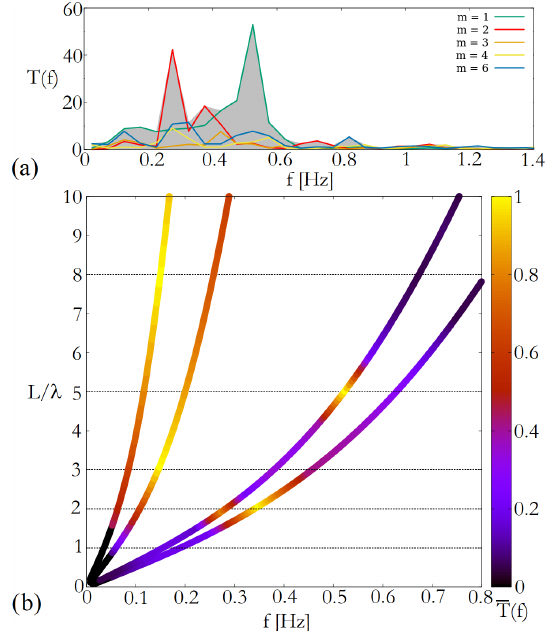
Figure 8. (a) The transfer functions T (f ) of all dominant excita- tion modes m in experiment series #1 and their cumulative transfer function (gray shaded area). (b) The internal wave (inverse) dis- persion relations as a function of frequency f for four exemplary stratification settings (representing series #1, #2, #3, and #4). The coloring marks the normalized cumulative transfer functions T (f ) as acquired from the corresponding experiment